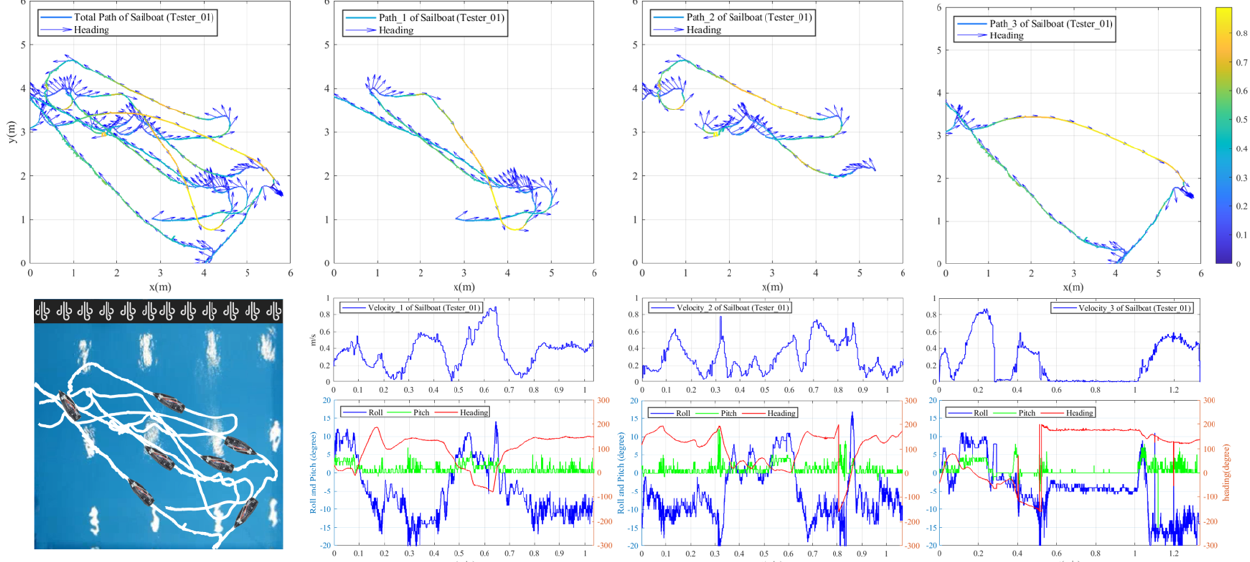
Figure 9. Remote sailing test (tester 01) in STAr. The leftmost figure of the first row and the remaining three figures are the total sailing path and the segmented paths, respectively. The arrow in the path indicates the heading. The graph in the second row is the path in the real test environment corresponding to the figure in the first row. The remaining three diagrams all contain the speed, roll, pitch and heading of the corresponding